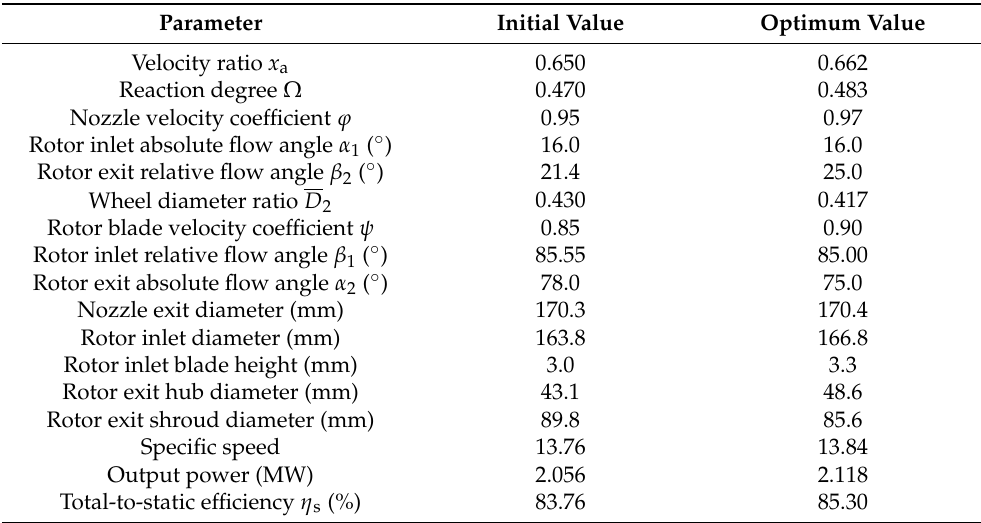
Table 4. Initial and optimum design